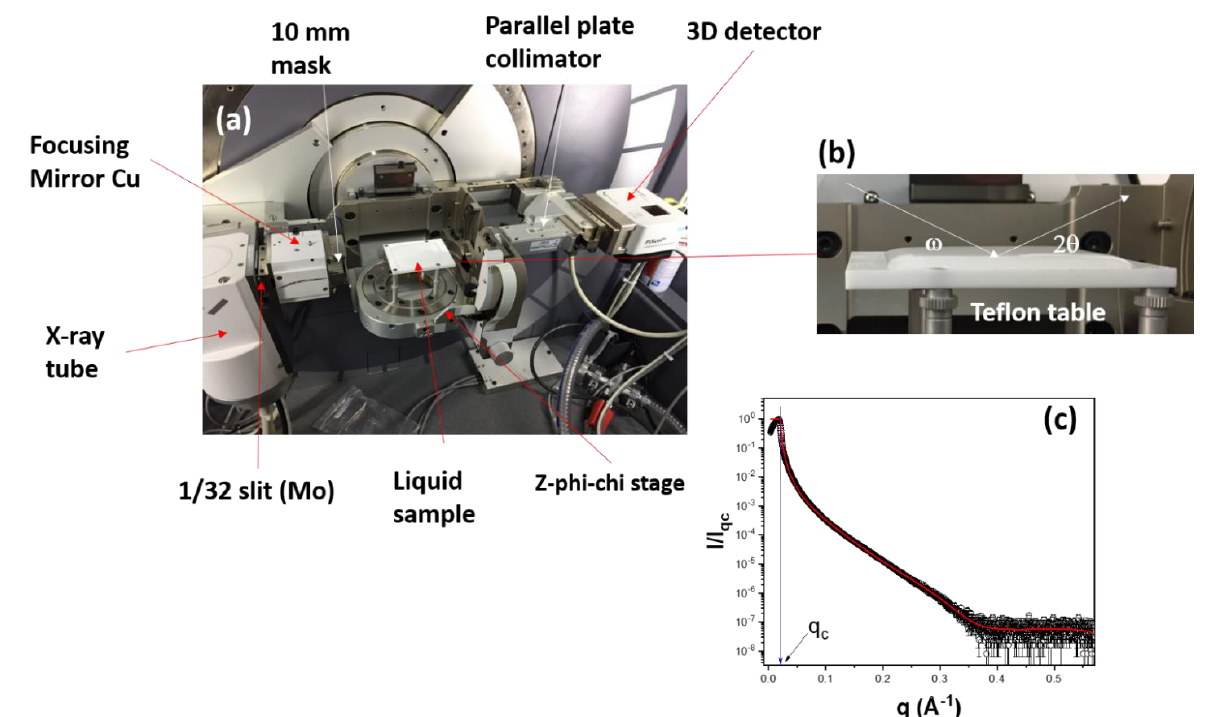
Figure 2. XRR experiments. ( a ) Description of the general setup for the experiments; ( b ) details of the liquid cell and geometry used for the measurements; ( c ) Typical XRR curve represented as the normalized intensity (I/Iqc) as a function of the wave vector, q. Iqc is the intensity at the critical angle of total reflectivity and qc is the corresponding wave vector.